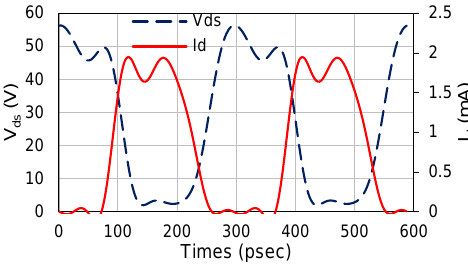
Figure 5. Simulated waveforms of the drain-source voltage and drain current at 3.5GHz.